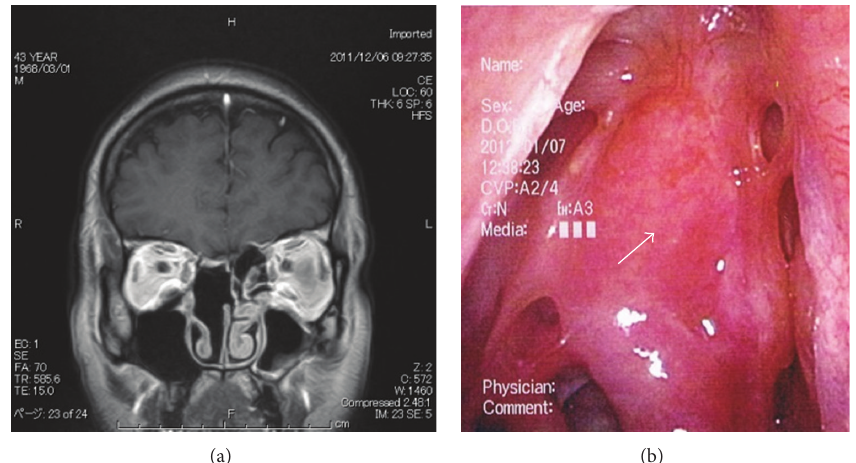
Figure 4: Postoperative MRI and local finding in case 1. (a) A T1-weighted coronal image (gadolinium+) showing no recurring mass. (b) The white arrow shows the pedicled nasal septal flap in the right nasal